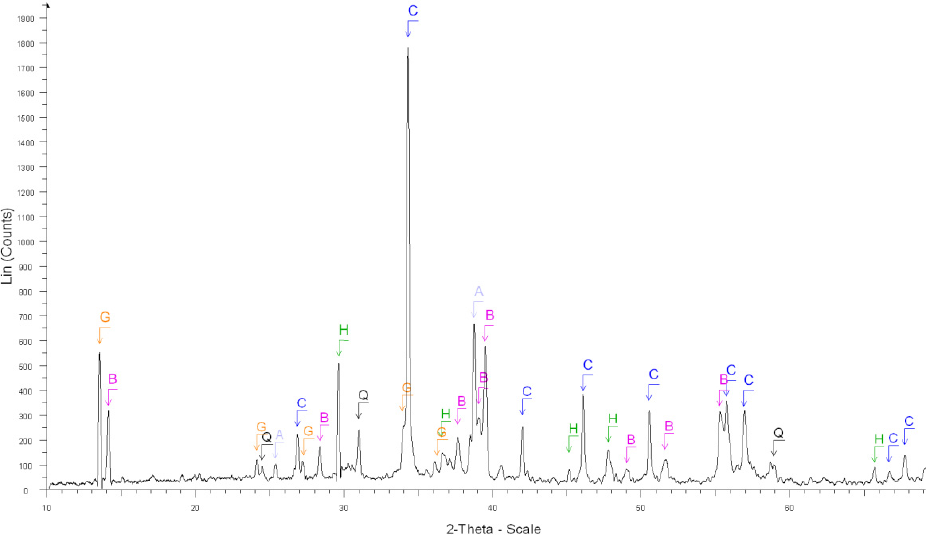
Figure 3. XRD diffractograms: After the dissolution of grey cement. C, B, H, G, Q, A and M stand for calcite, brownmillerite, anhydrite, gypsum, quartz, calcium aluminum oxide and calcite magnesian, respectively.